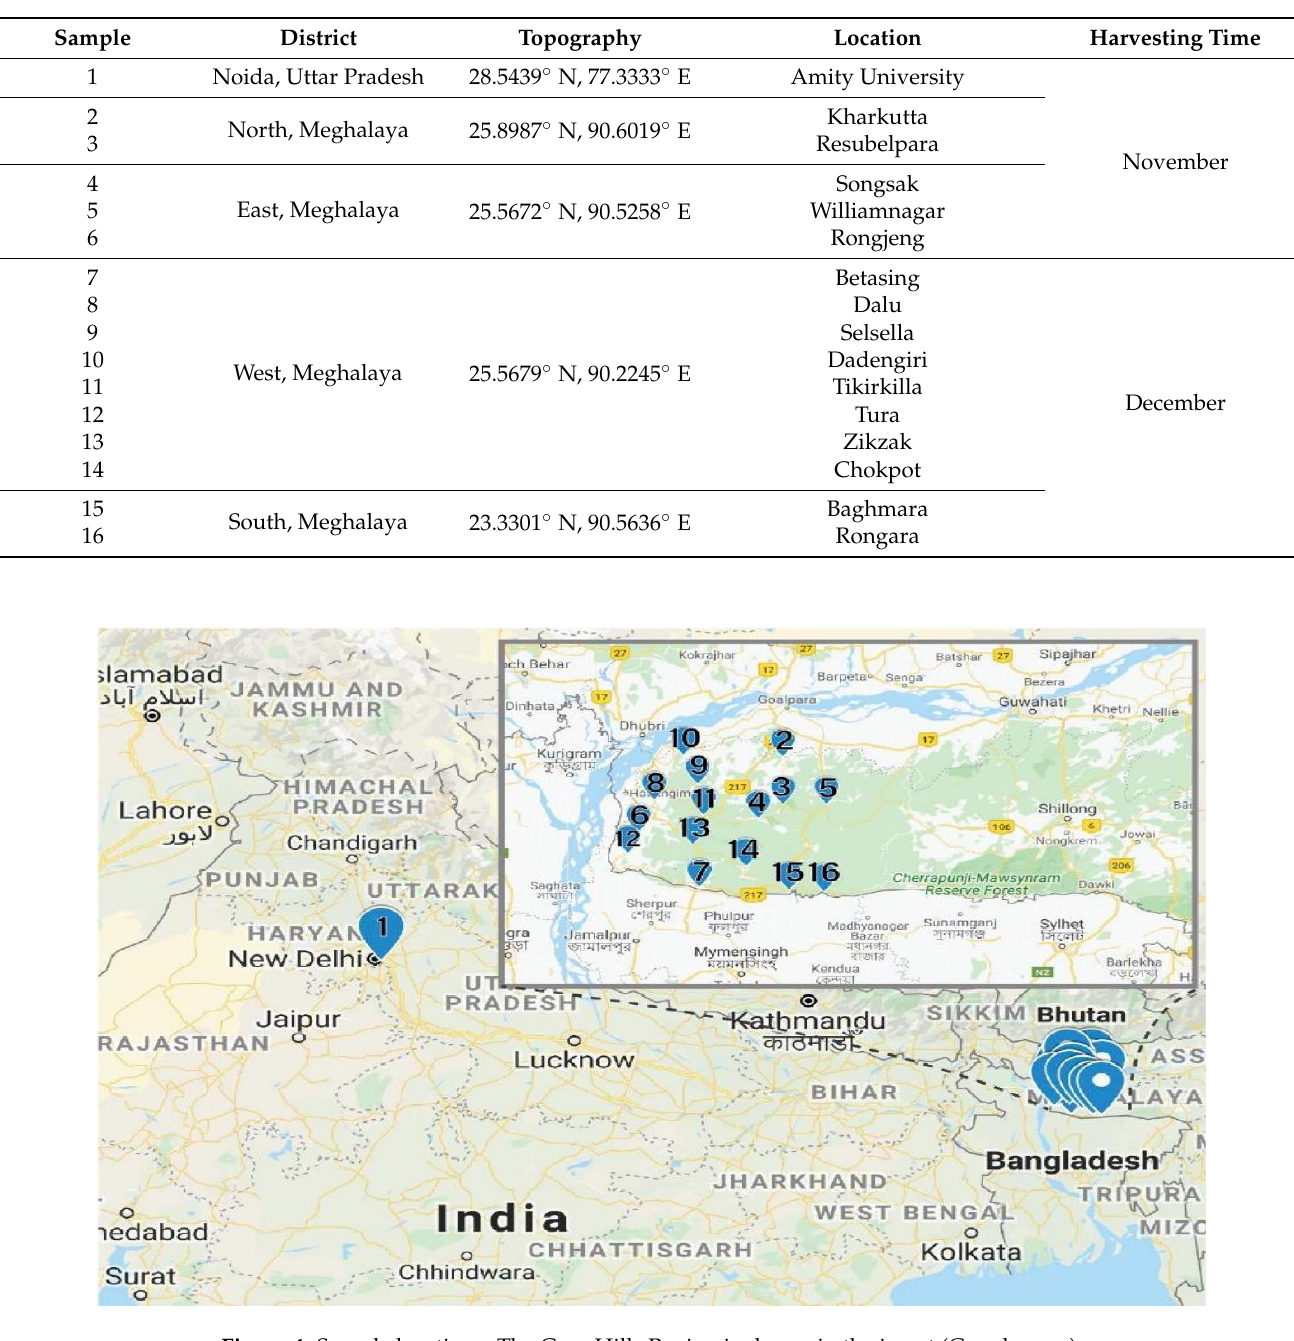
Figure 4. Sample locations. The Garo Hills Region is shown in the insert (Google map).